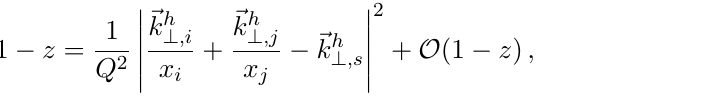
. The three-momentum of a pair of ;s ? . The corresponding i;j and ~k h . Soft radiation acts ;i ;j ? ?